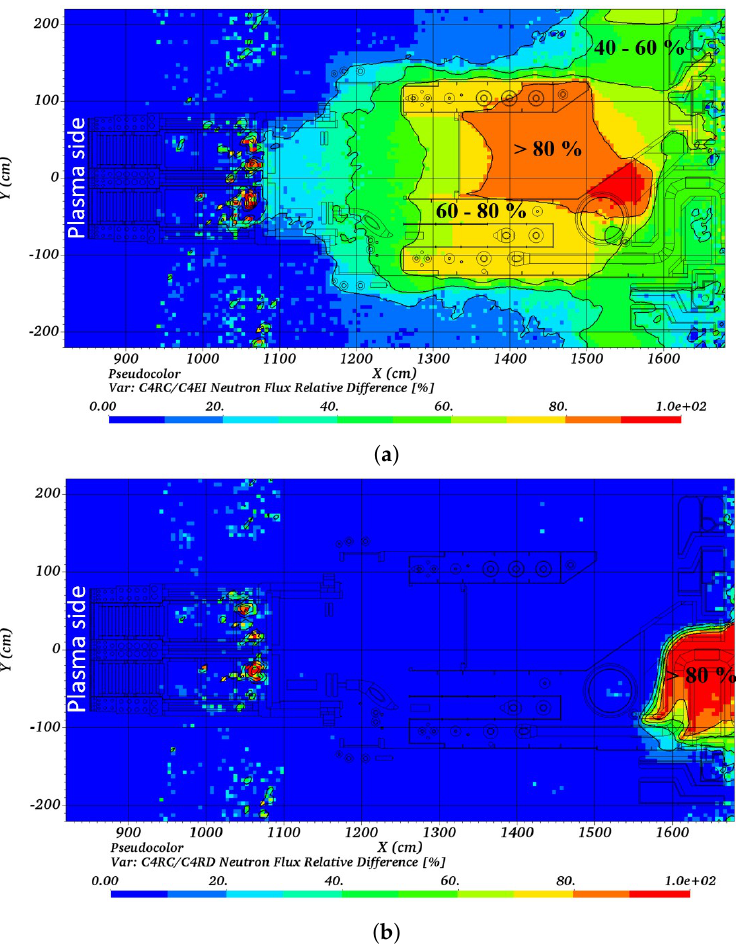
Figure 7. Relative neutron flux reduction in PI due to ( a ) PF (C4EI) and ( b ) BP (C4RD)